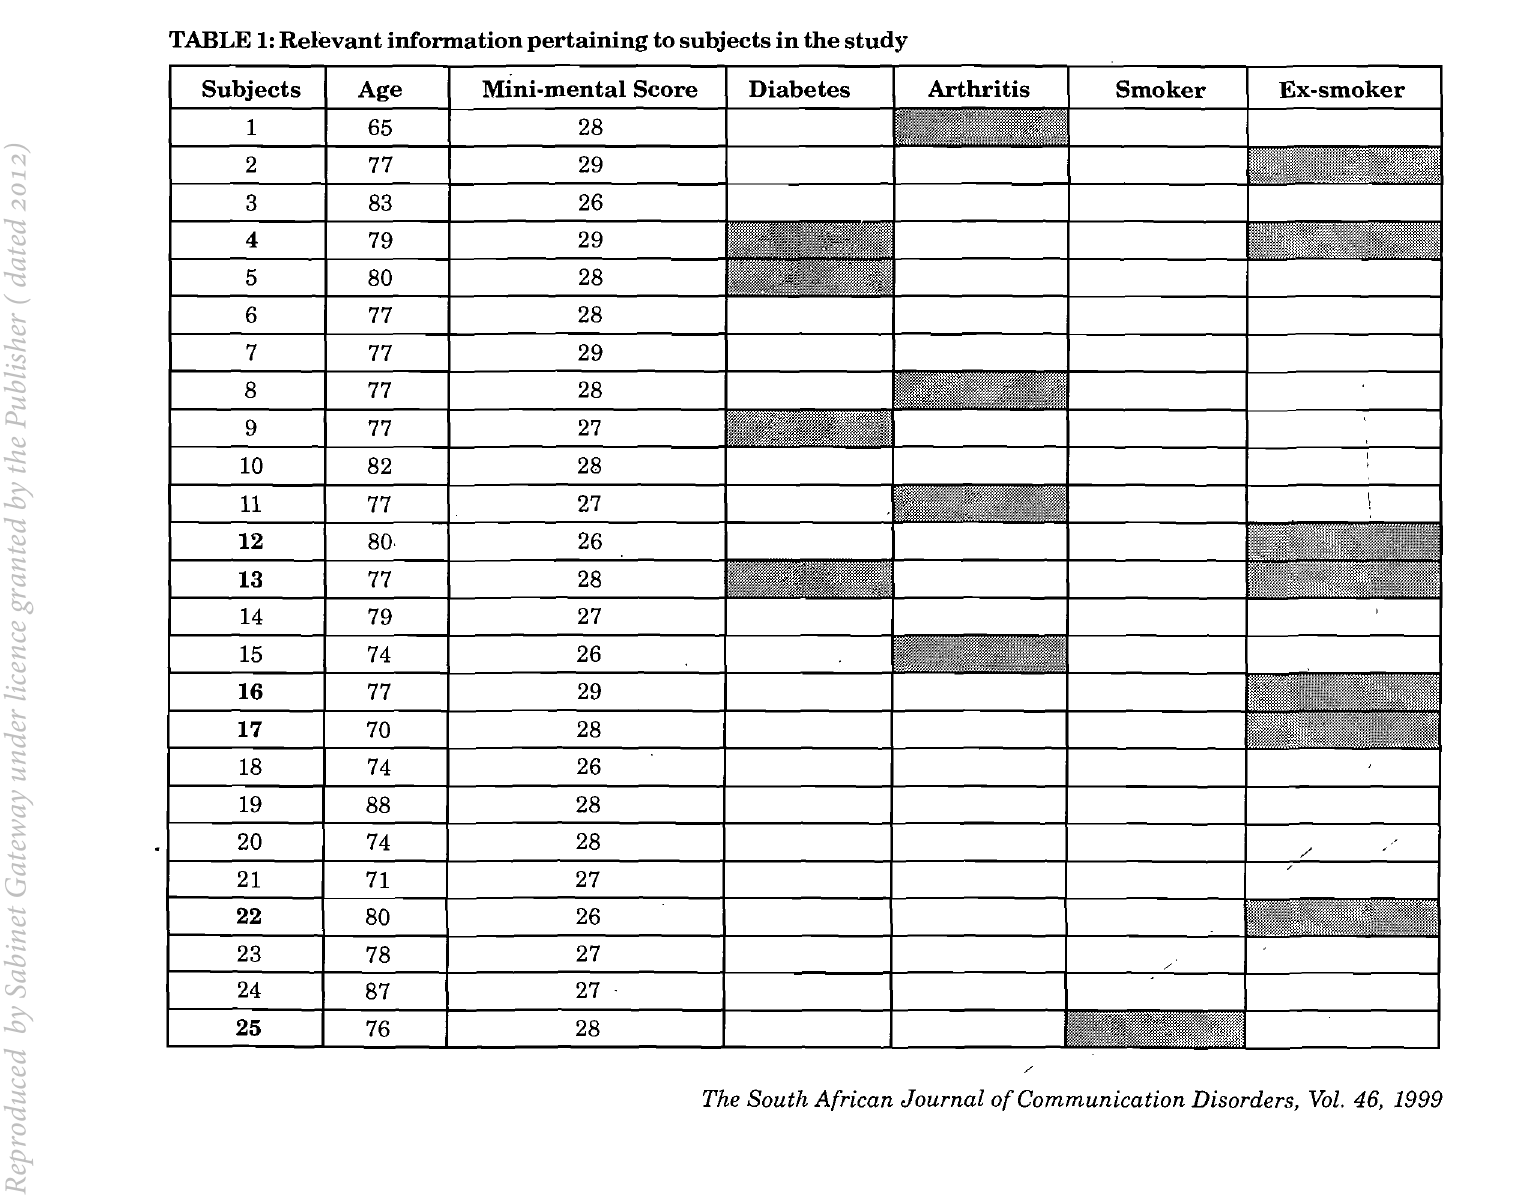
TABLE 1: Relevant information pertaining to subjects in the study